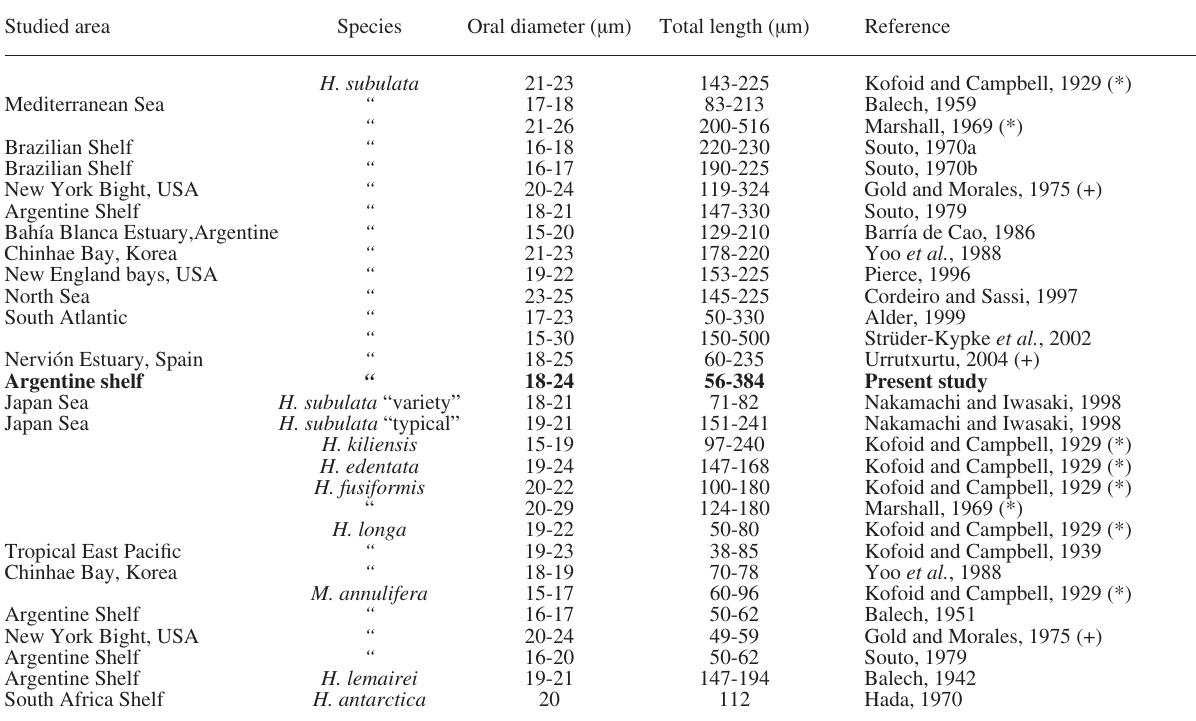
Table 4. – Morphometric features of Helicostomella spp. and metacylis annulifera reported in systematic studies subsequent to that of Kofoid and campbell (1929). revisions of the suborder tintinnina (*); ecological studies (+). Studied